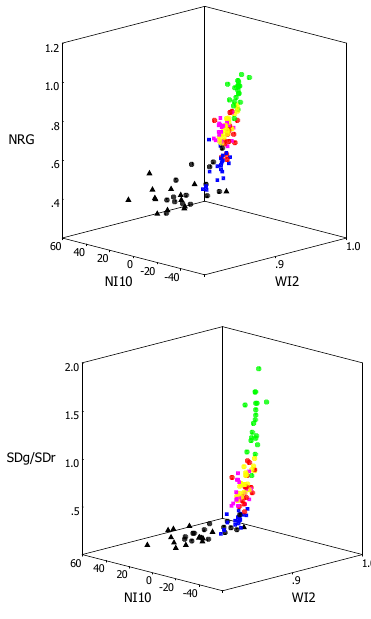
Figure 7. Two Typical Spectral Index Space